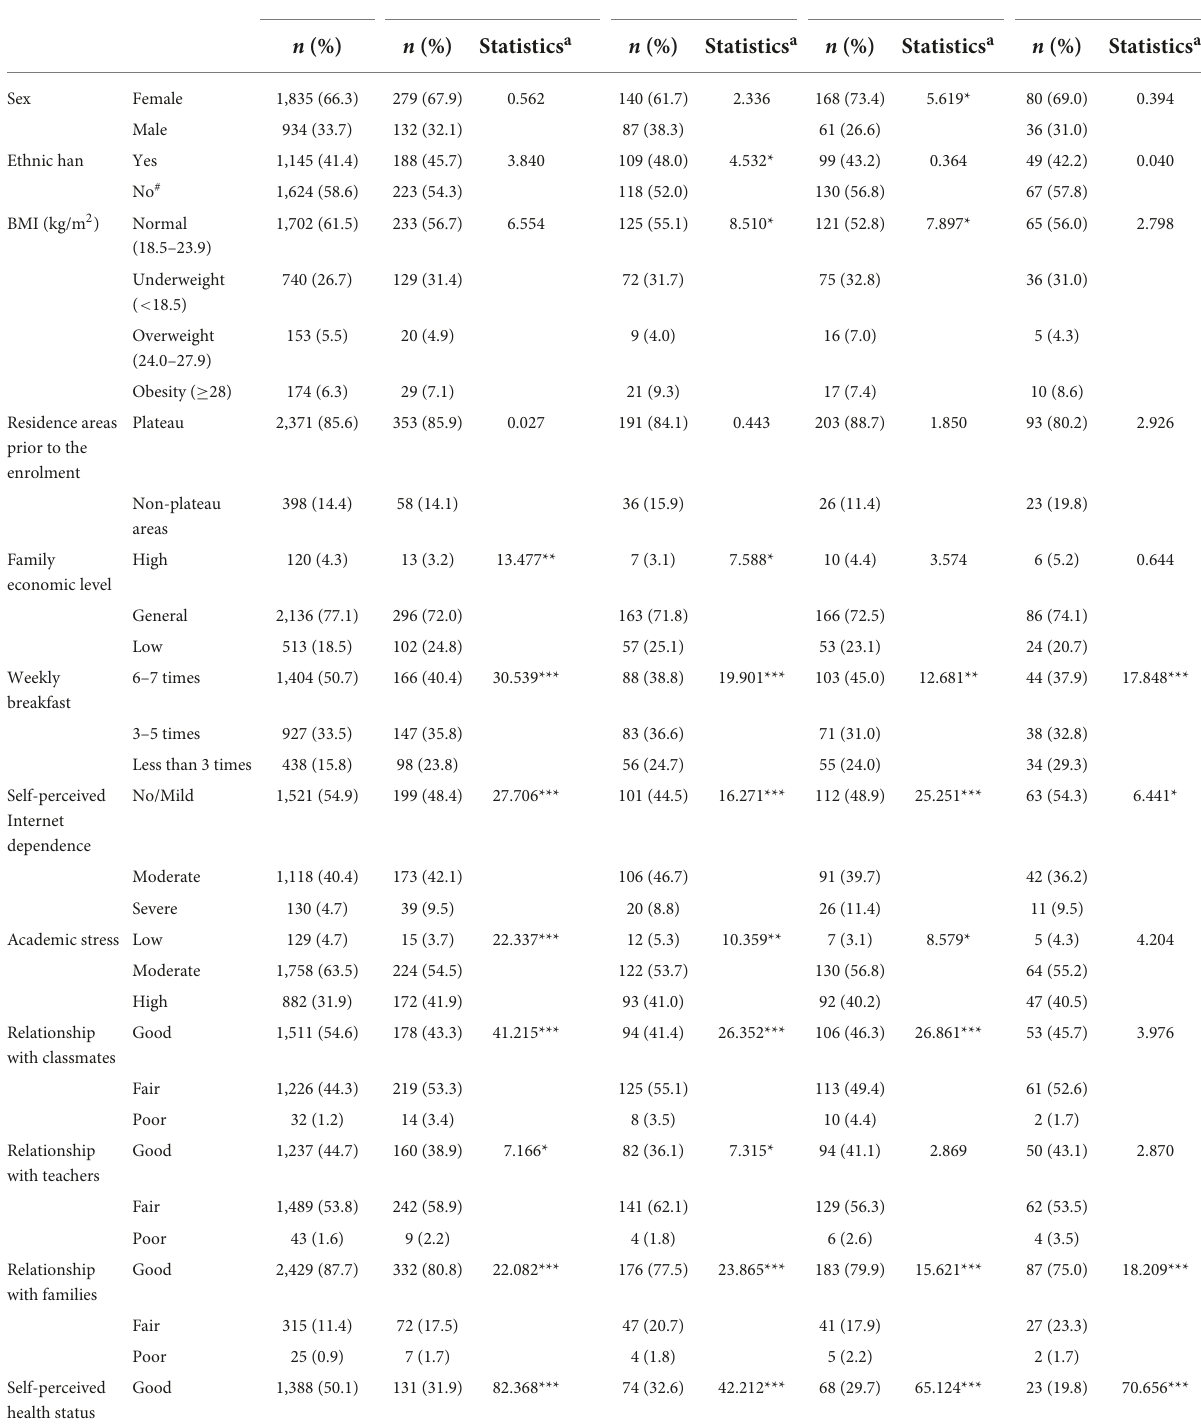
TABLE 1 Sociodemographic characteristics of the